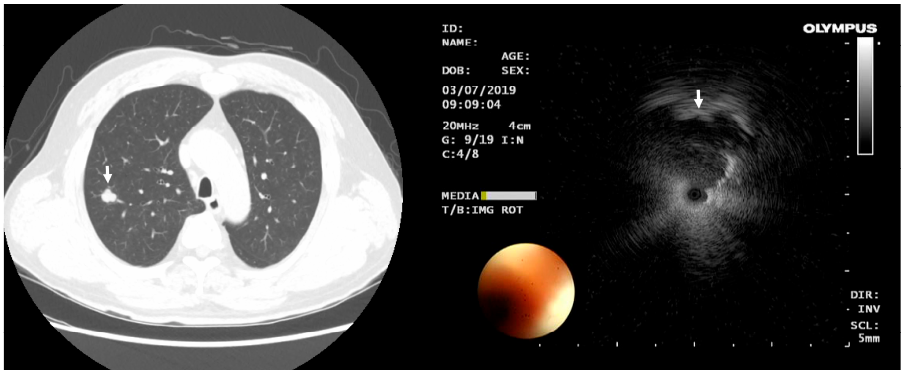
Figure 1. Preoperative CT scan and transbronchial marking procedure. The location and type of nodules (white arrow) was identified through CT before surgery; based on this, localization was performed using MIL via tranbronchial approach.